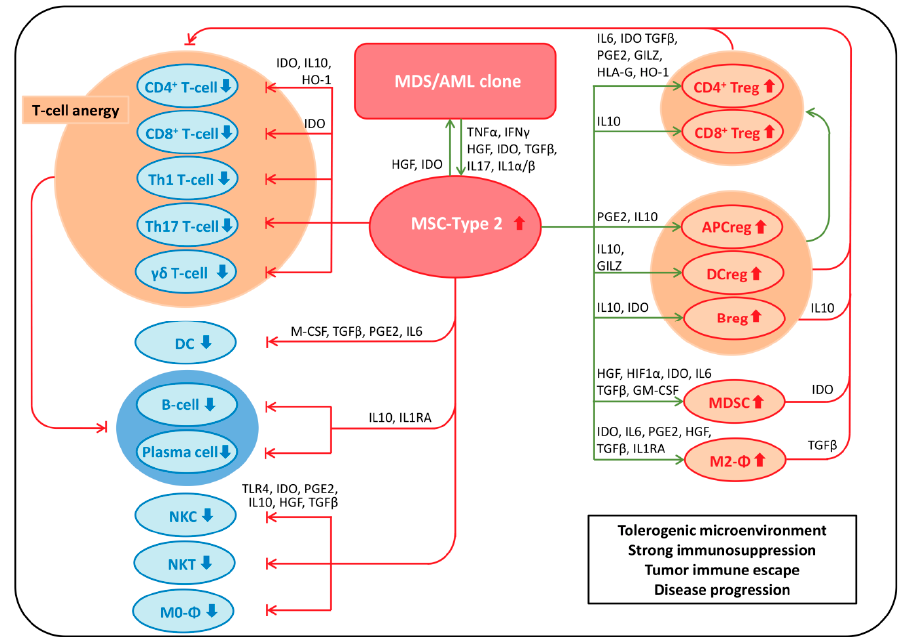
Figure 4. Mechanisms of mesenchymal stem and progenitor cells (MSPC)-mediated immune suppression and evasion. Early-stage myelodysplastic syndromes (MDS) are associated with a state of inflammation. The inflammatory bone marrow (BM) microenvironment is believed to